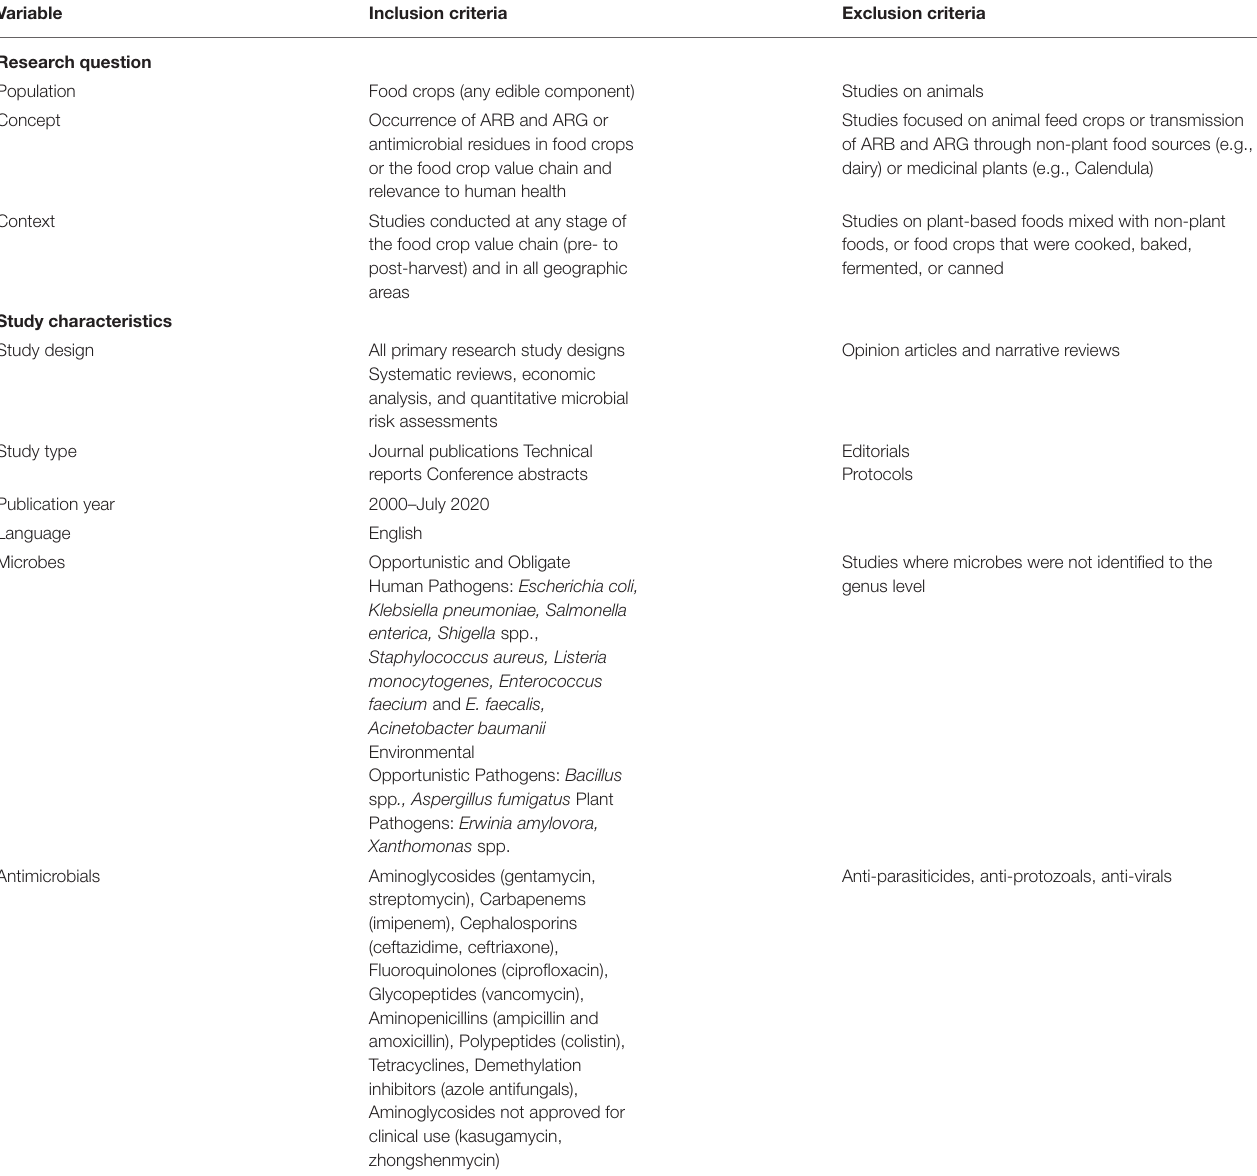
TABLE 1 | Eligibility